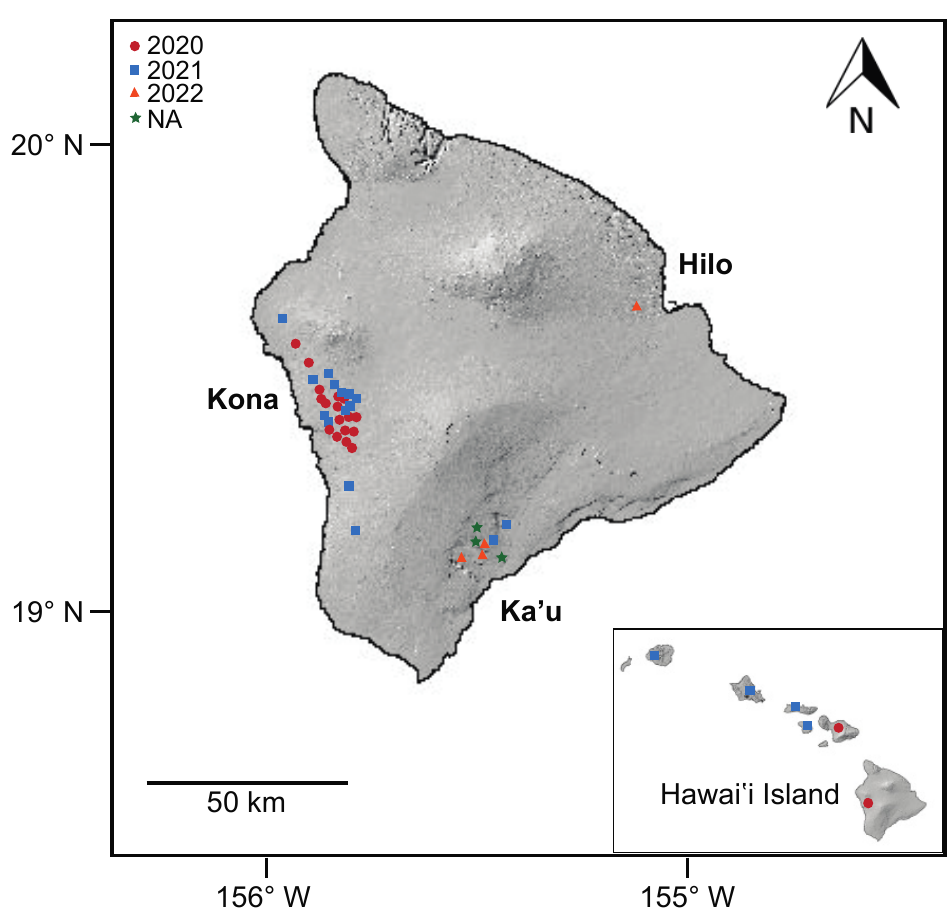
Figure 1. Map of Hawaii Island showing positive coffee leaf rust (CLR) detections on surveyed commercial coffee farms across the growing regions of Kona, Ka’u and Hilo. Colored symbols refer to the year that CLR was detected (see top left legend); “NA” means that CLR has not yet been detected on these farms. Inset map shows location of Hawaii Island within the Hawaiian archipelago and the spread of CLR up the island chain.